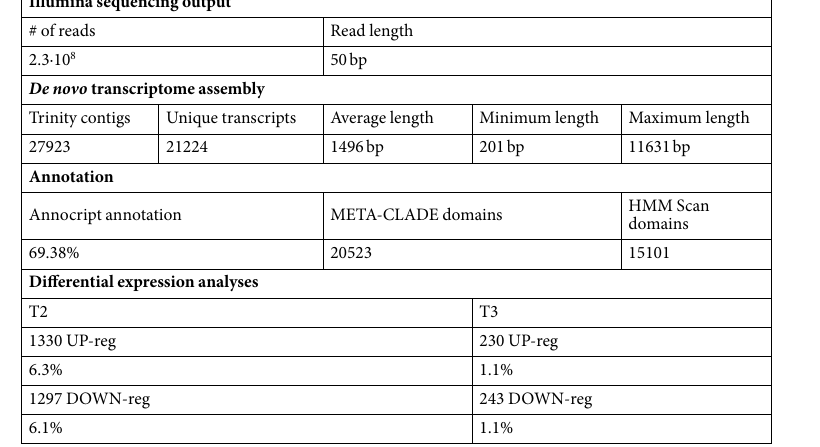
Table 1. Transcriptome statistics and differential analyses